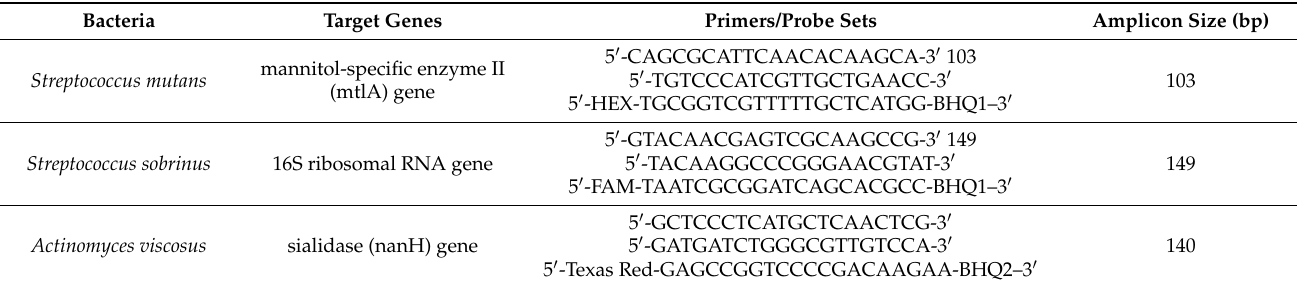
Table 1. Primers and probes used in the real-time PCR assays.